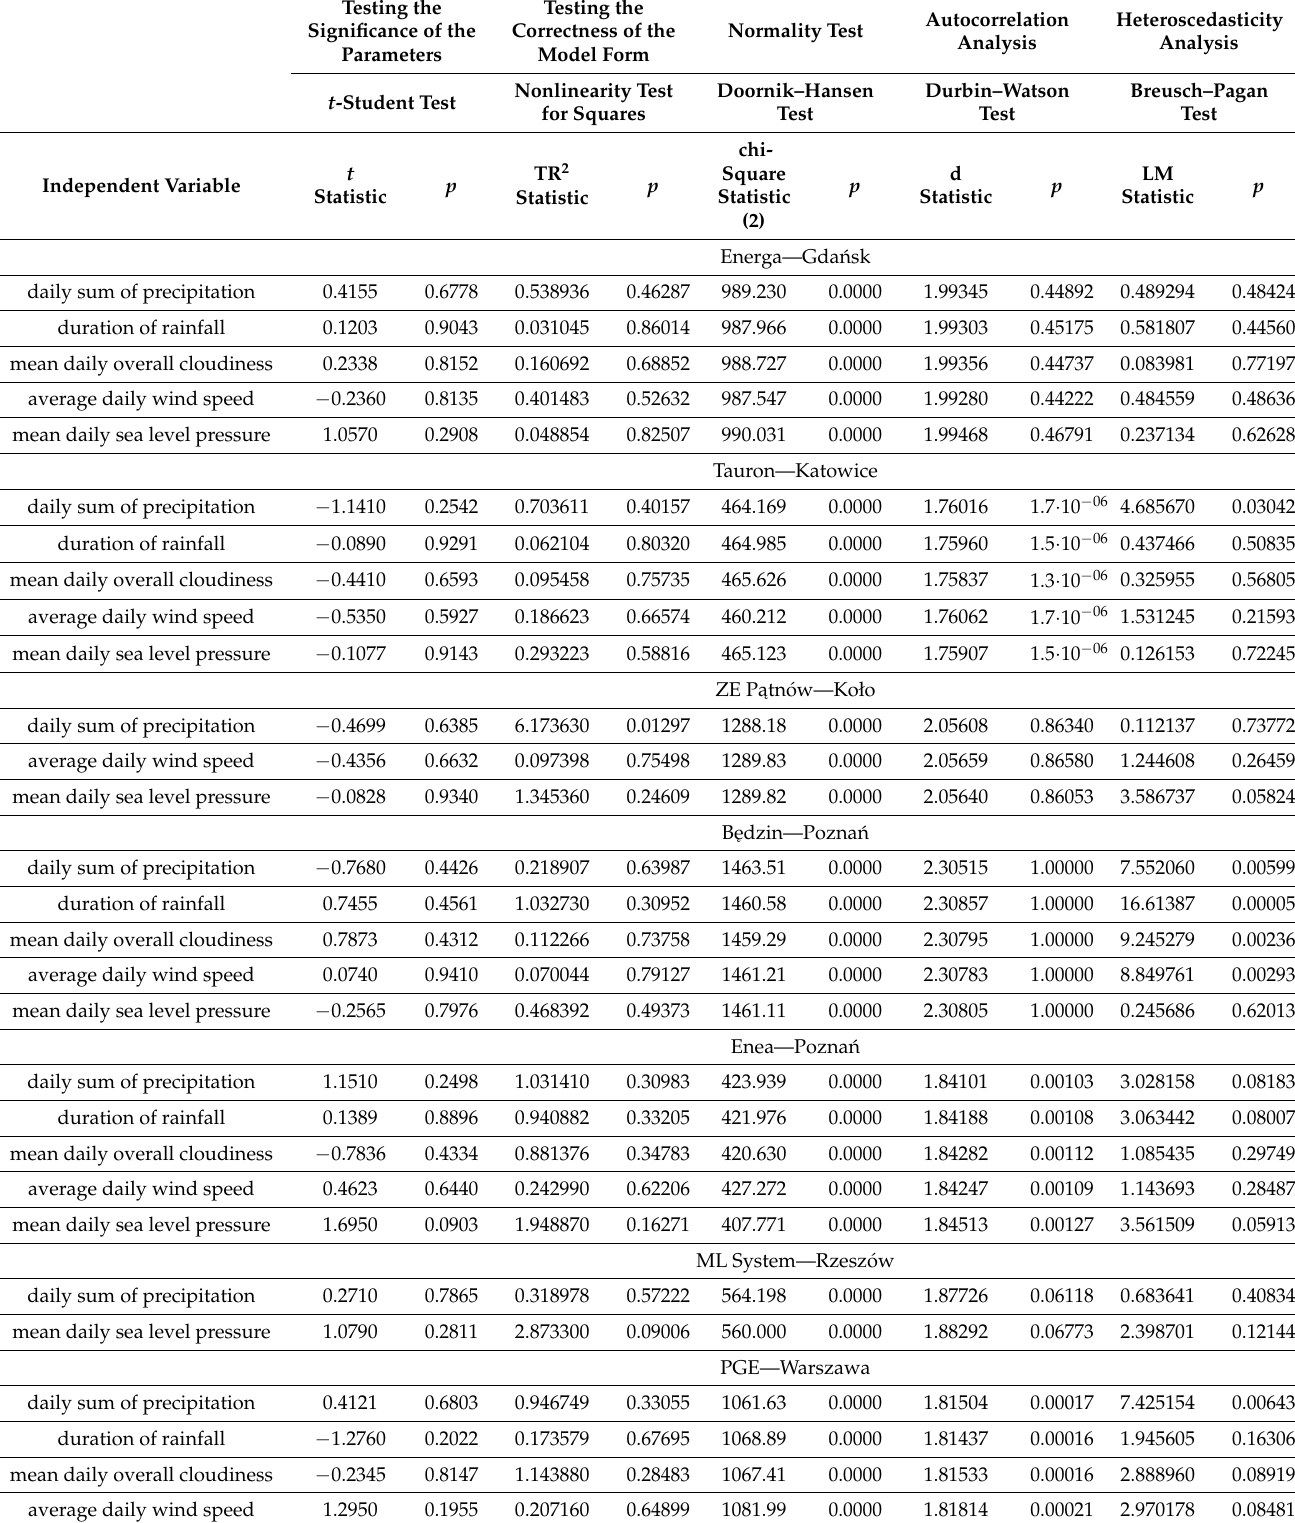
Table 4. OLS estimation results for the rate of return depending on the stationary weather factor along with testing the properties of the residual